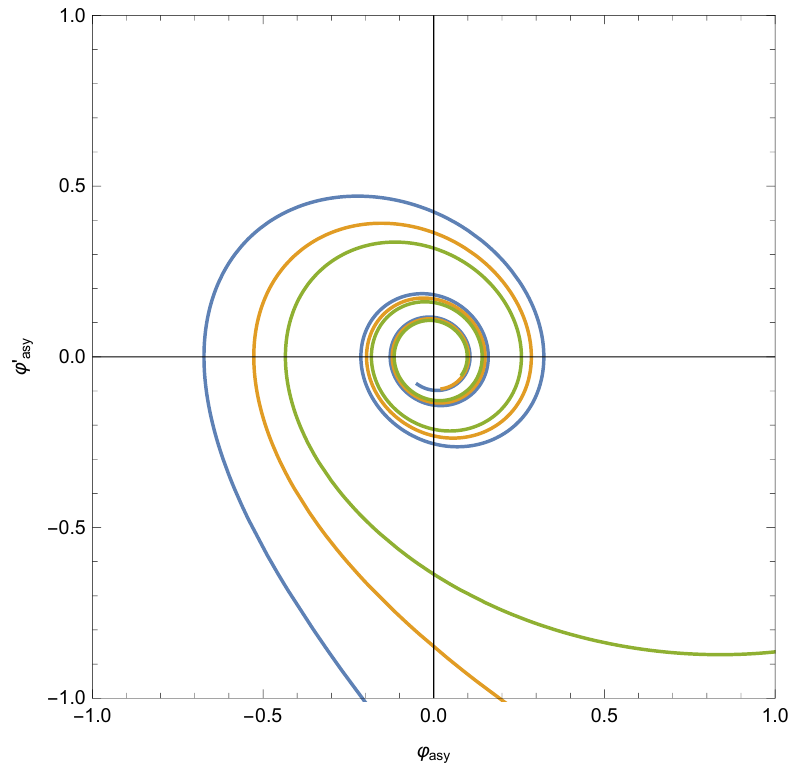
Figure 2. Three typical asymptotic trajectories on the phase map of the differential Equation (21) corresponding to the quadratic potential. Note that, for sufficiently large times, the approximation of the representative point to the origin is